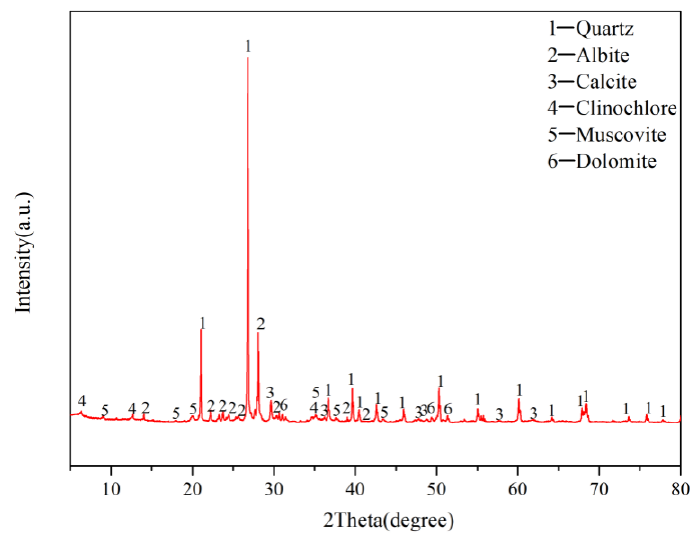
Figure 3. XRD pattern of a soil sample.